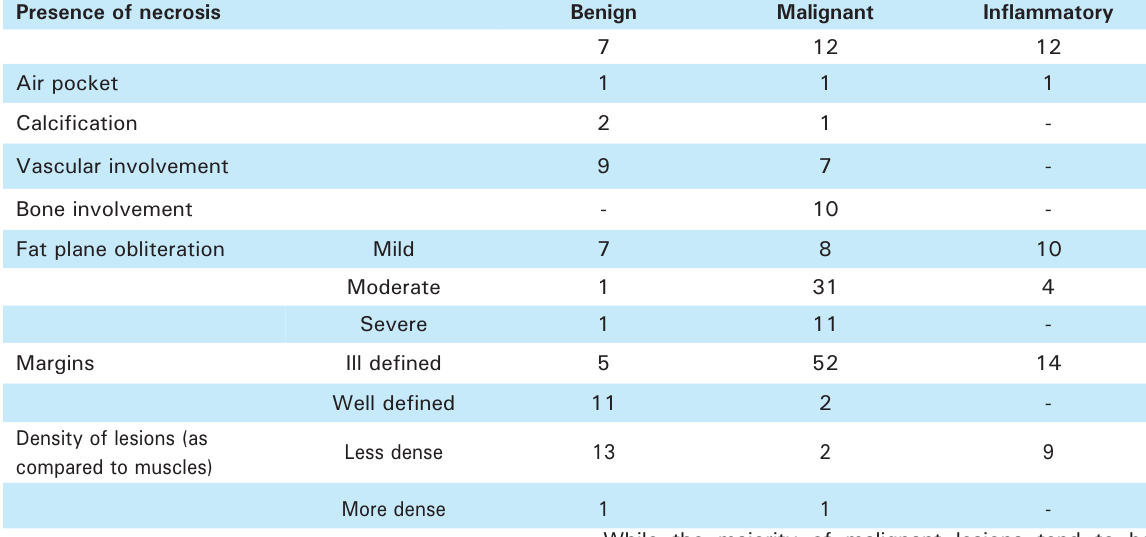
Table 3. CT features of different lesions